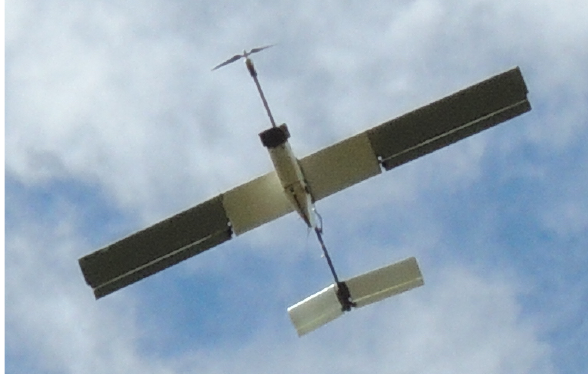
2.1.2 Platform and sensor: We used the Falcon UAS, to collect the images (Photo 2). This small fixed-wing is electrically powered, has a wingspan of 2,5 m and weights 6